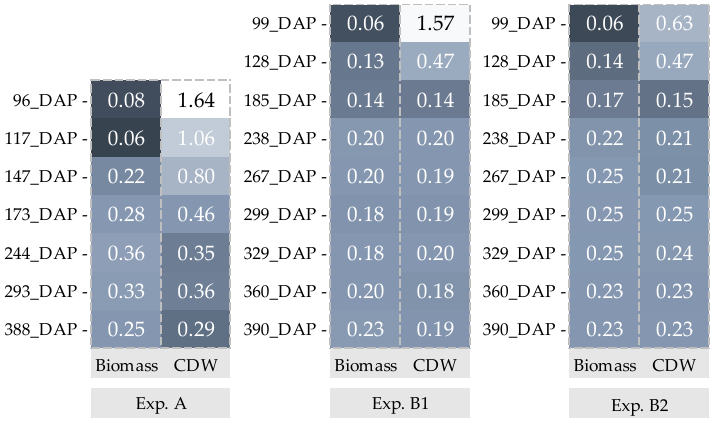
Figure 3. Relationship between APSIM-simulated values and emulator-predicted values of biomass and CDW in experiment B1 at each reporting frequency at days after planting (DAP): 99, 128, 185, 238, 267, 299, 329, 360 and 390. Solid lines indicate linear fit to the APSIM-simulated values and emulator-predicted values of biomass and CDW.